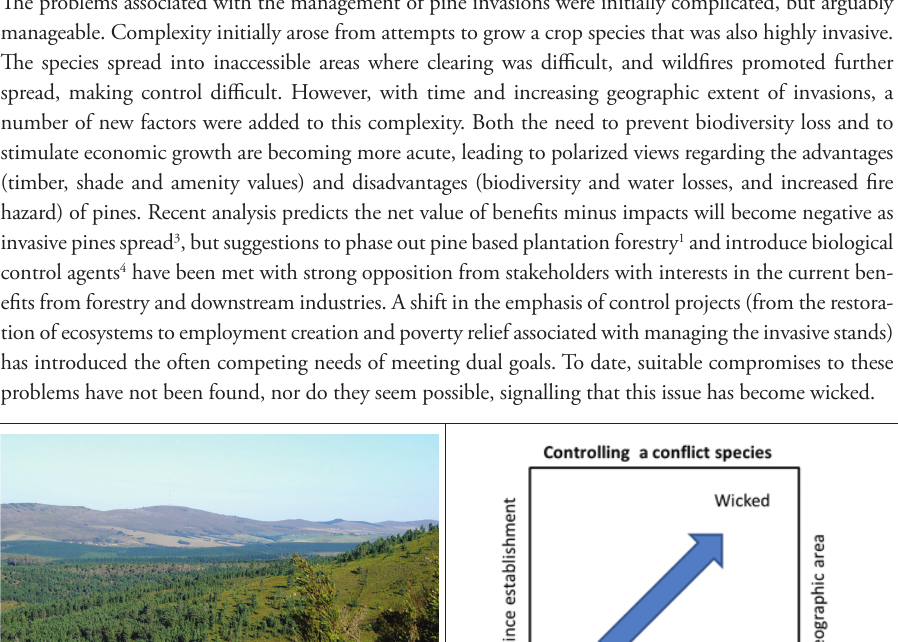
Figure B4-1. Invasive pines spreading from a plantation in the Cape Floristic Region.